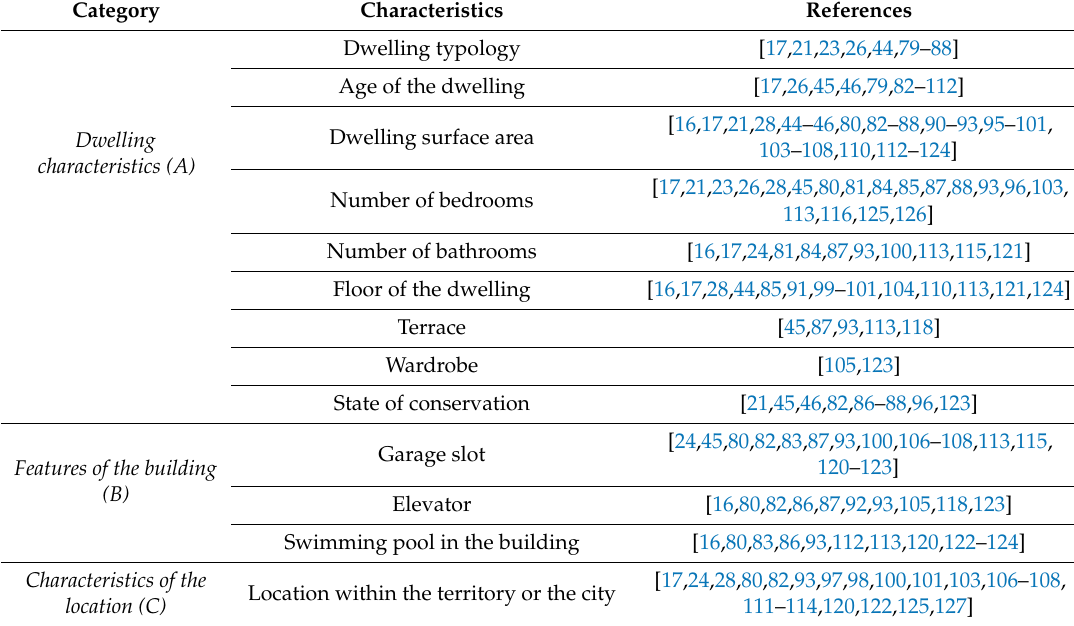
Table A2. Variables used by other authors for the determination of the price of housing. Own elaboration from